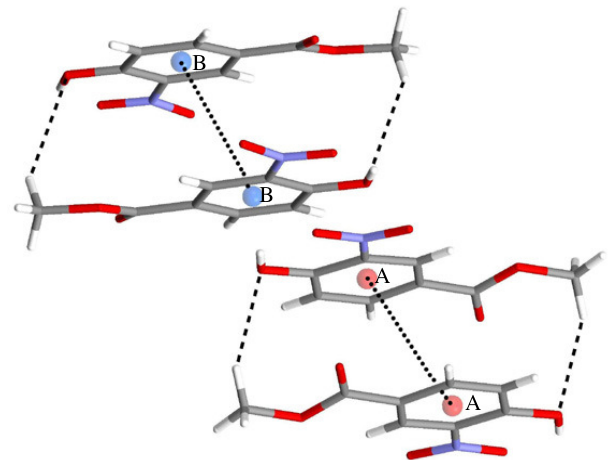
Figure 3. Centrosymmetric dimers formed by π ··· π contacts (dotted lines) and weak C—H···O interactions dashed lines. The red spheres represent centroids of the benzene rings in the A molecules and the blue sphere those in the B molecules.